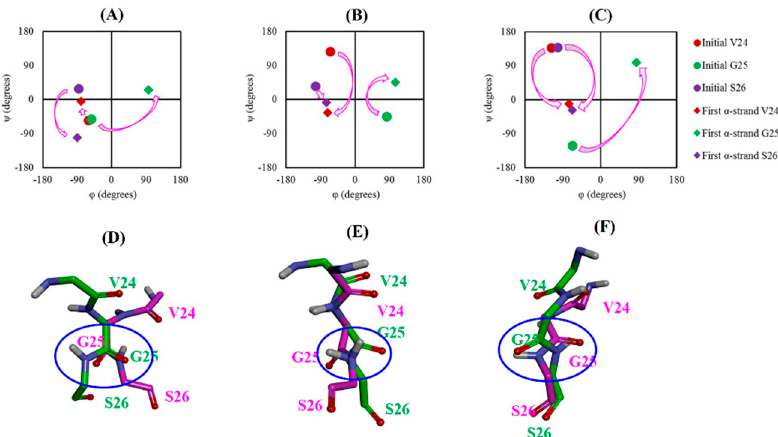
Figure 3. Transition of dihedrals ( ϕ , ψ ) for α -strand formation: ( A ) System 4 (1IYT, WT, NpH, 498K), ( B ) System 5 (1Z0Q, WT, NpH, 498K) and ( C ) System 6 (2NAO, WT, NpH, 498K). Initial and first α -strand represents dihedrals of the specific residue in the initial PDB structure and first α -strand structure observed during MD simulation, respectively. Peptide-plane flipping: ( D ) System 4 (1IYT, WT, NpH, 498K), ( E ) System 5 (1Z0Q, WT, NpH, 498K) and ( F ) System 6 (2NAO, WT, NpH, 498K). Backbone atoms of the α -strand forming residues are shown by the stick model. Side chains and non-polar hydrogen atoms are not shown for the sake of clarity. Initial conformation of the residues at the beginning of production run is displayed by the pink stick model whereas the first α -strand conformation is shown by the green stick model. Flip of the CO-NH plane is highlighted by the blue